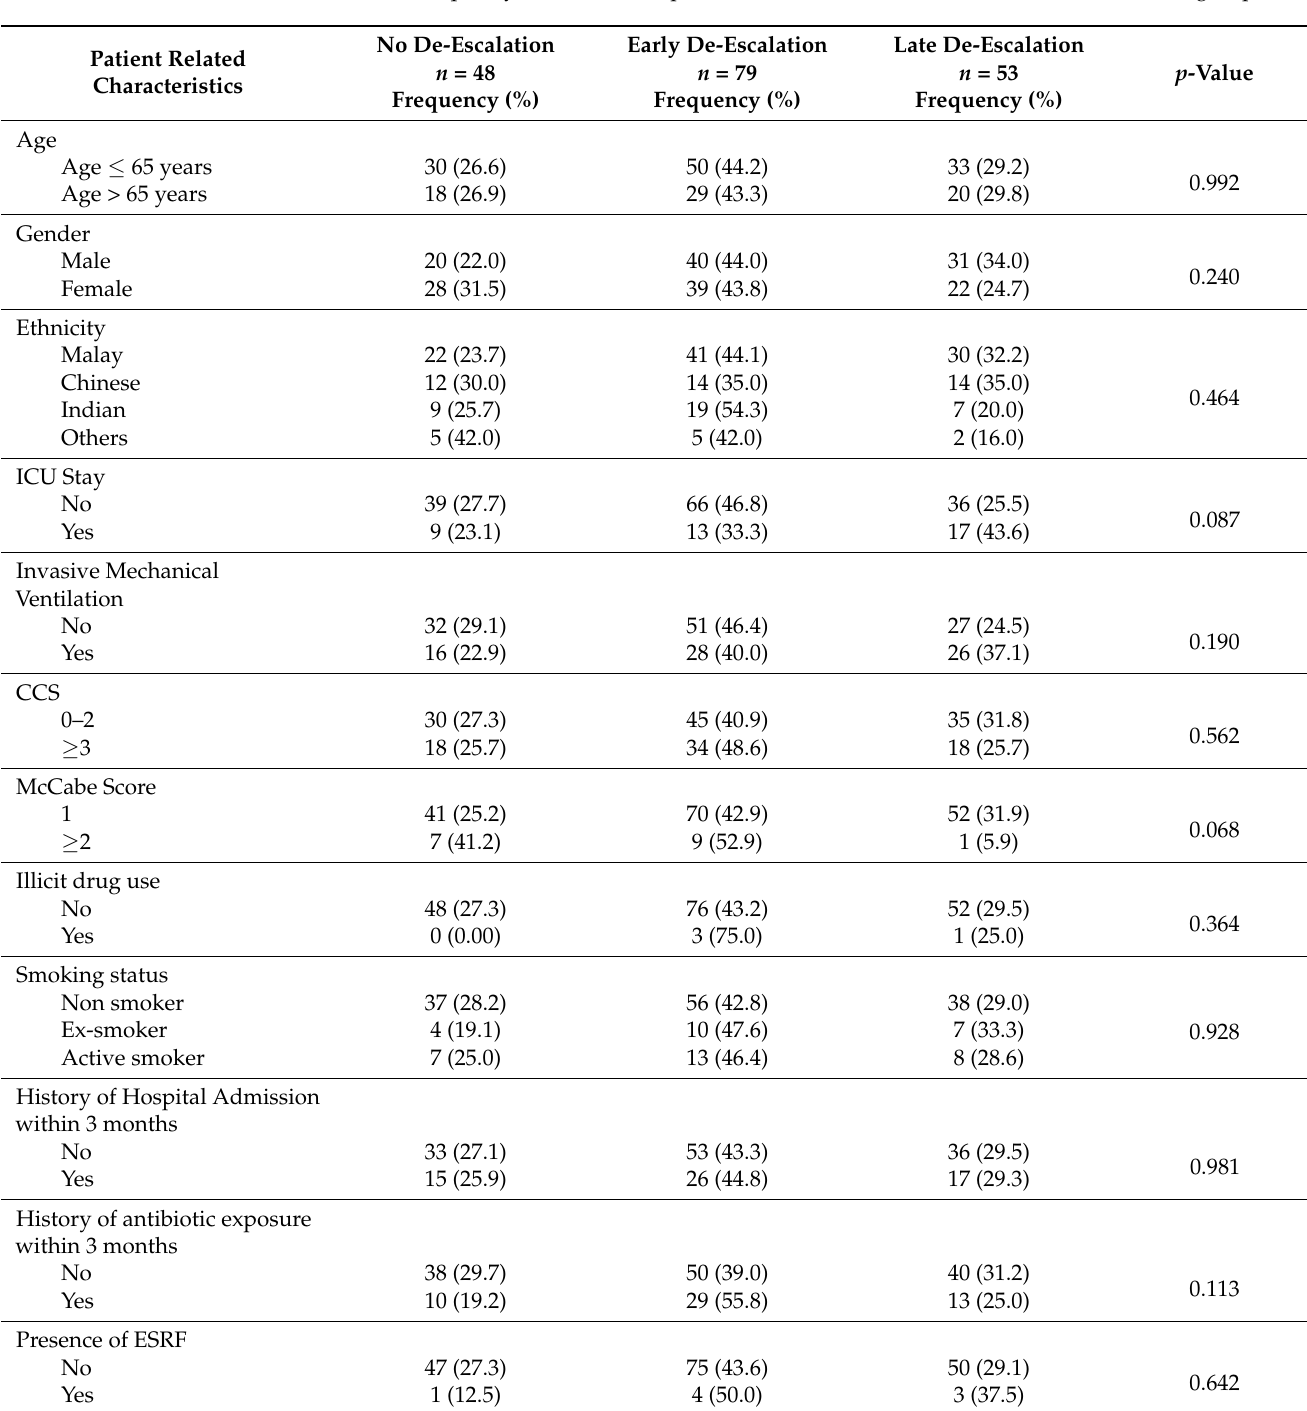
Table 1. Frequency distribution of patient related characteristics based on de-escalation